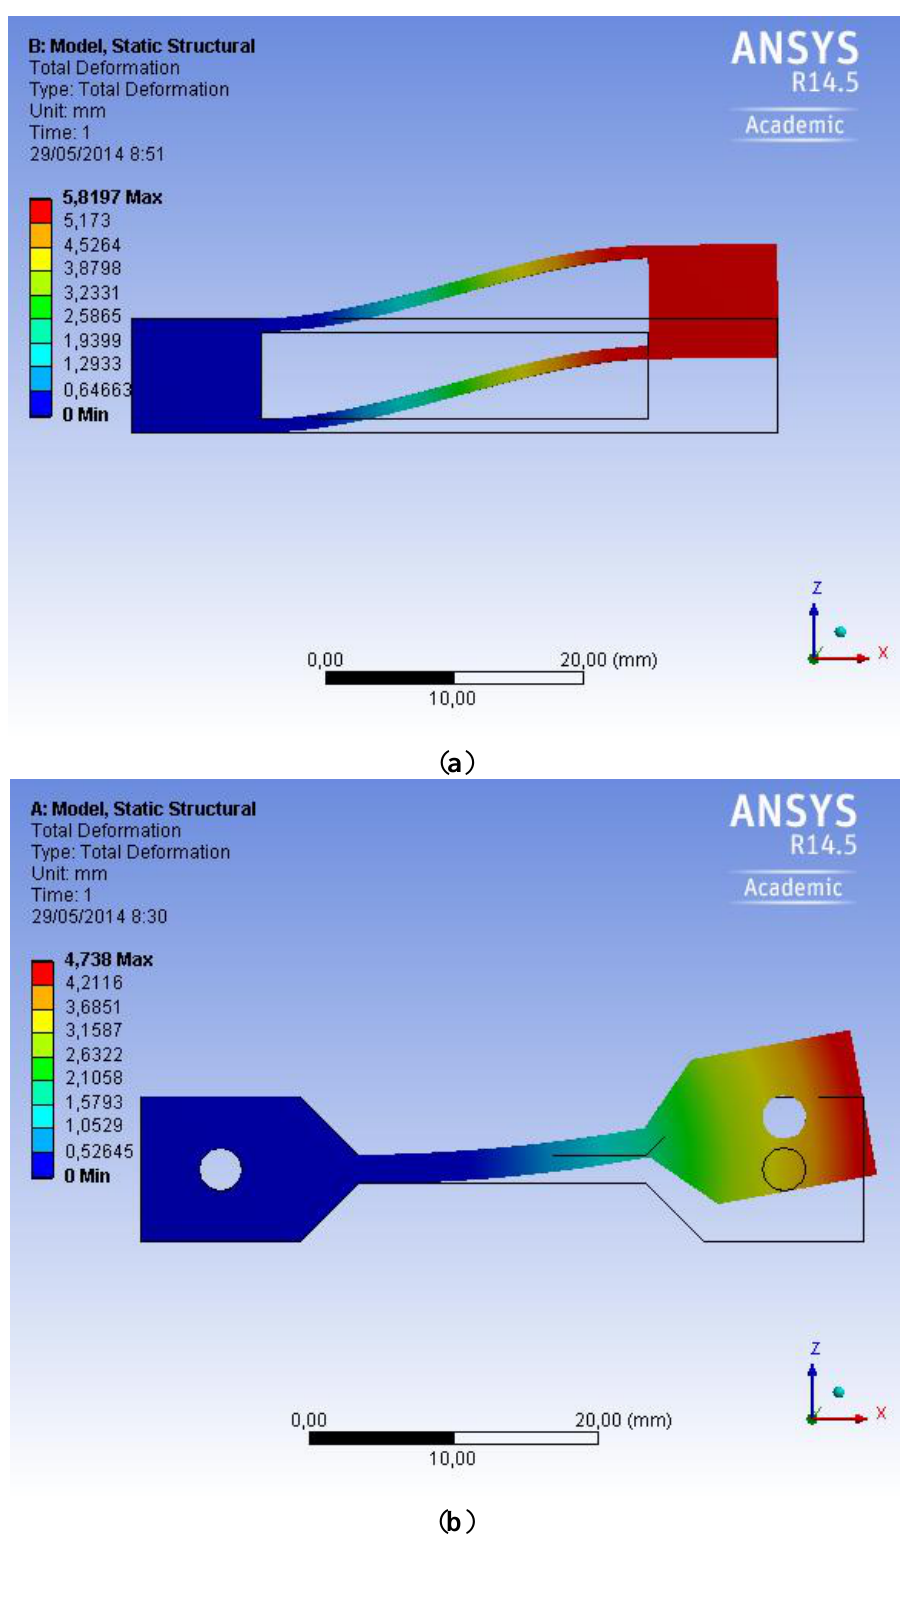
Figure 5. ( a ) Joint to replace sliders, ( b – d ) to replace